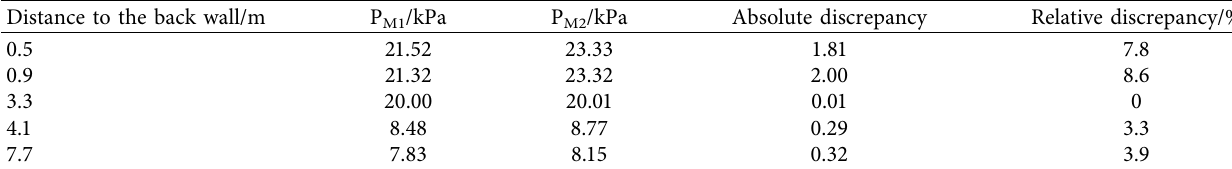
Table 2: The comparison results of peak